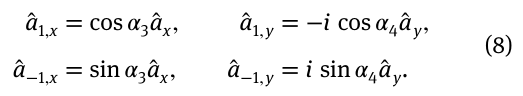
+ E + E to E to the right and E x y x y + E + i E to E to the right and E x y x y and 𝜙  . The phase gradient of 𝜙  and 𝜙  of supercell  is same as xx yy xx yy − 𝜙  = 𝜋 . (c) For metasurface M2, 𝜙  ′ and 𝜙  ′ have the opposite linear gradient. The yy xx xx yy − 𝜙  ′ = − 3 𝜋 ∕ 2 and 𝜙  ′ − 𝜙  ′ = − 𝜋 ∕ xx yy yy xx